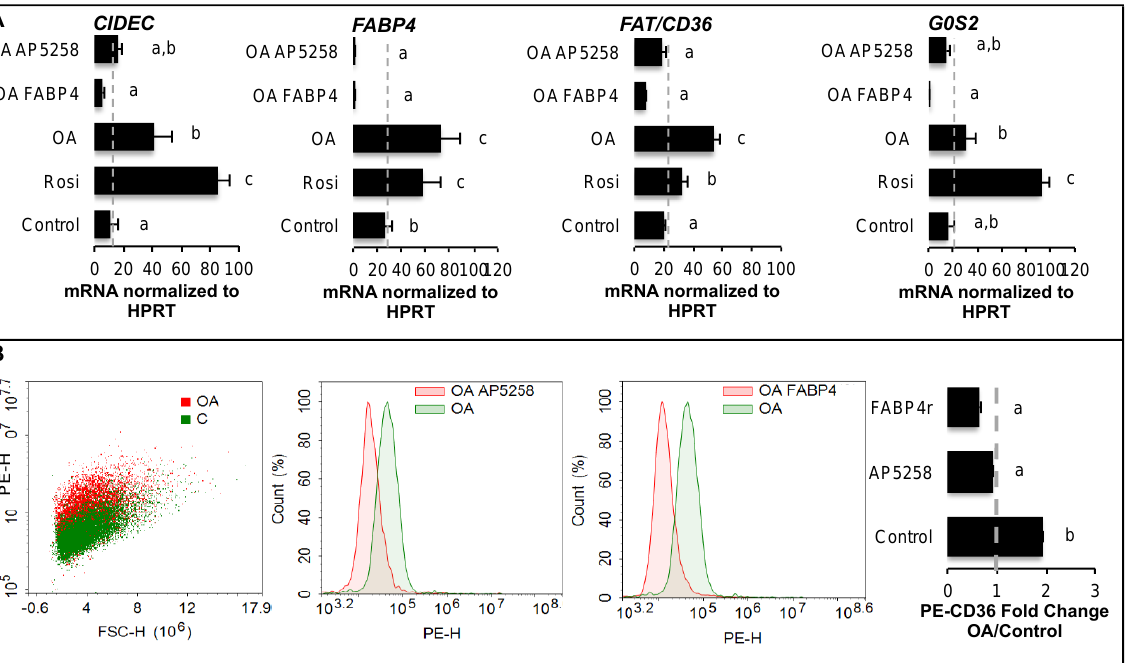
Figure 8. Fatty acid binding protein 4 (FABP4) inhibits the pro-adipogenic programme mediated by fatty acid/FAT/CD36 pathways in 3T3-L1 fibroblasts. Treatments were performed in DMEM high glucose media over 24 h with oleic acid (OA 0.5 µ M), recombinant FABP4 (FABP4 20 ng/mL), FAT/CD36 inhibitor (AP5258, 1 µ M) or rosiglitazone (Rosi 10 µ M). ( A ) Gene transcription analyses by qRT-PCR, normalized to HPRT standard, show the inhibitory effect of FABP4 and FAT/CD36 inhibition on their own induction by OA. ( B ) Phycoerythrin (PE)-coupled anti CD36 antibody was analyzed by cytometry and showed that both FABP4r and FAT/CD36 inhibitor reversed the induction of extracellular FAT/CD36 by OA. Data are presented as mean values +/- SEM (( A ): n = 8 biological replicates, ( B ): 4 replicates; at least 5000 cells/sample) with significant differences represented by letters (ANOVA p -values <